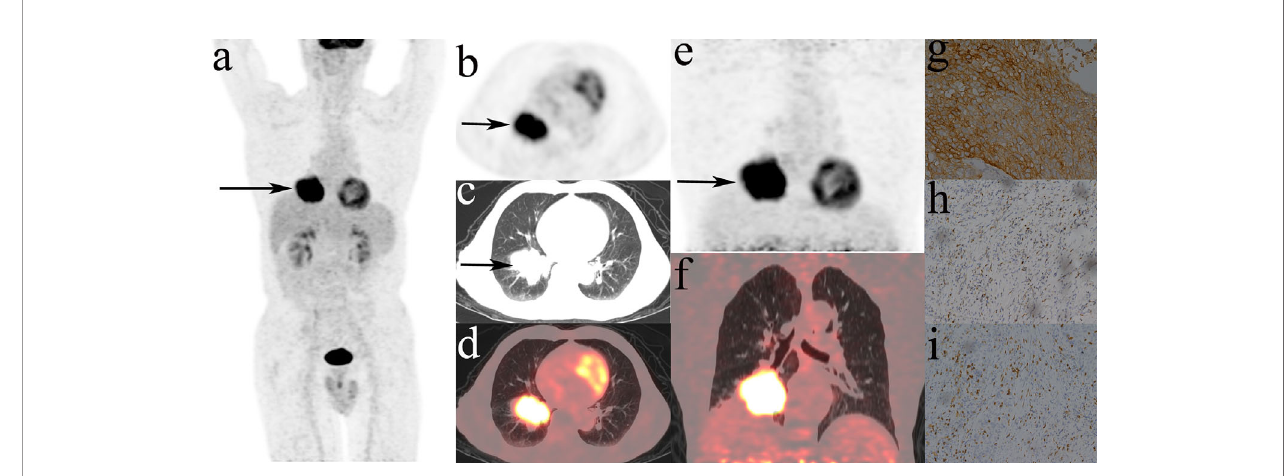
FIGURE 5 | Representative DTP 18 F-FDG PET/CT imagings of a 71y male patients, de fi ned as TMIT I tumor. (A – D) : early images, (E, F) : delayed images, (A) : MIP fi gure, (B – D) : PET, lung window, PET/CT fusion image. A mass was in the lower lobe of right lung (arrow) with markedly increased radioactivity, eSUVmax: 20.3, eSUVmean: 12.0, eMTV: 52.9 cm 3 , eTLG: 634.8 g, dSUVmax: 27.7, dSUVmean: 16.0, dMTV: 49.16 cm 3 , dTLG: 786.56 g. The surgical pathology: moderately differentiated squamous cell carcinoma. (G) high PD-L1 expression. (H) PD-1 TIL high density. (I) CD8 + TIL high density.